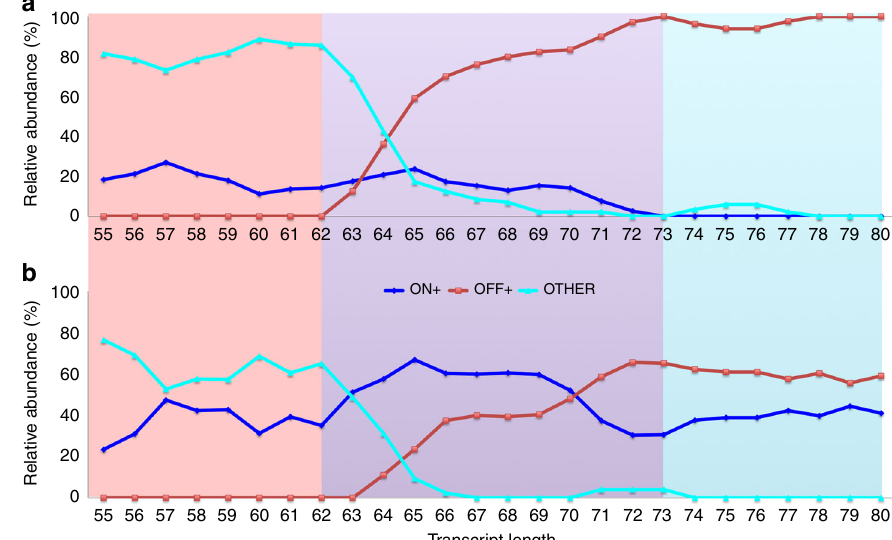
Fig. 4 Quantitative analysis of the cotranscriptional structure landscape of crcB fl uoride riboswitch based on SLEQ outputs. Relative abundance trajectories of ON+, OFF+, and OTHER clusters in the absence a and presence b of fl uoride, as dependent on intermediate transcript length. The structures output by SLEQ were manually assigned into clusters according to whether they feature certain motifs that are key to ON and OFF structures functionality. The ON+ cluster includes structures that contain PK1. The OFF+ cluster includes structures containing P1 and the forming